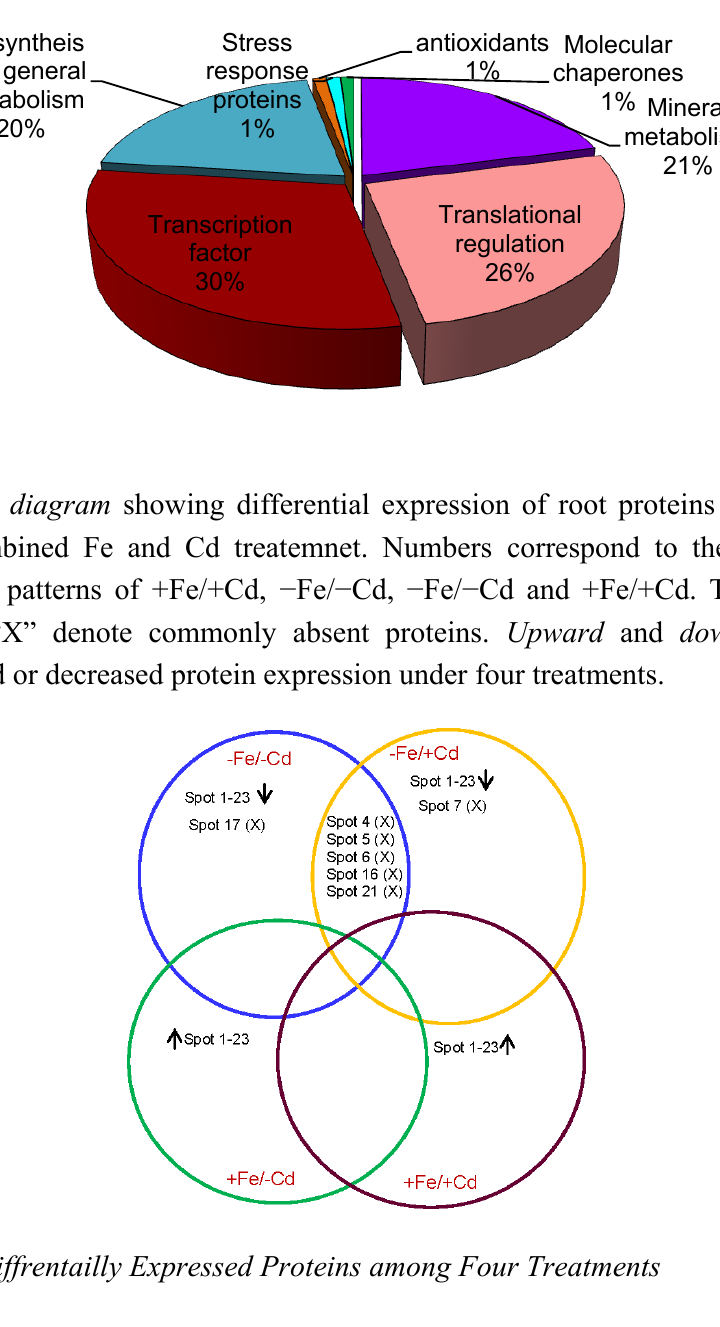
Figure 3. Functional classification of identified proteins from leaves analyzed by MALDI-TOF-MS as described by Beven et al. [20].